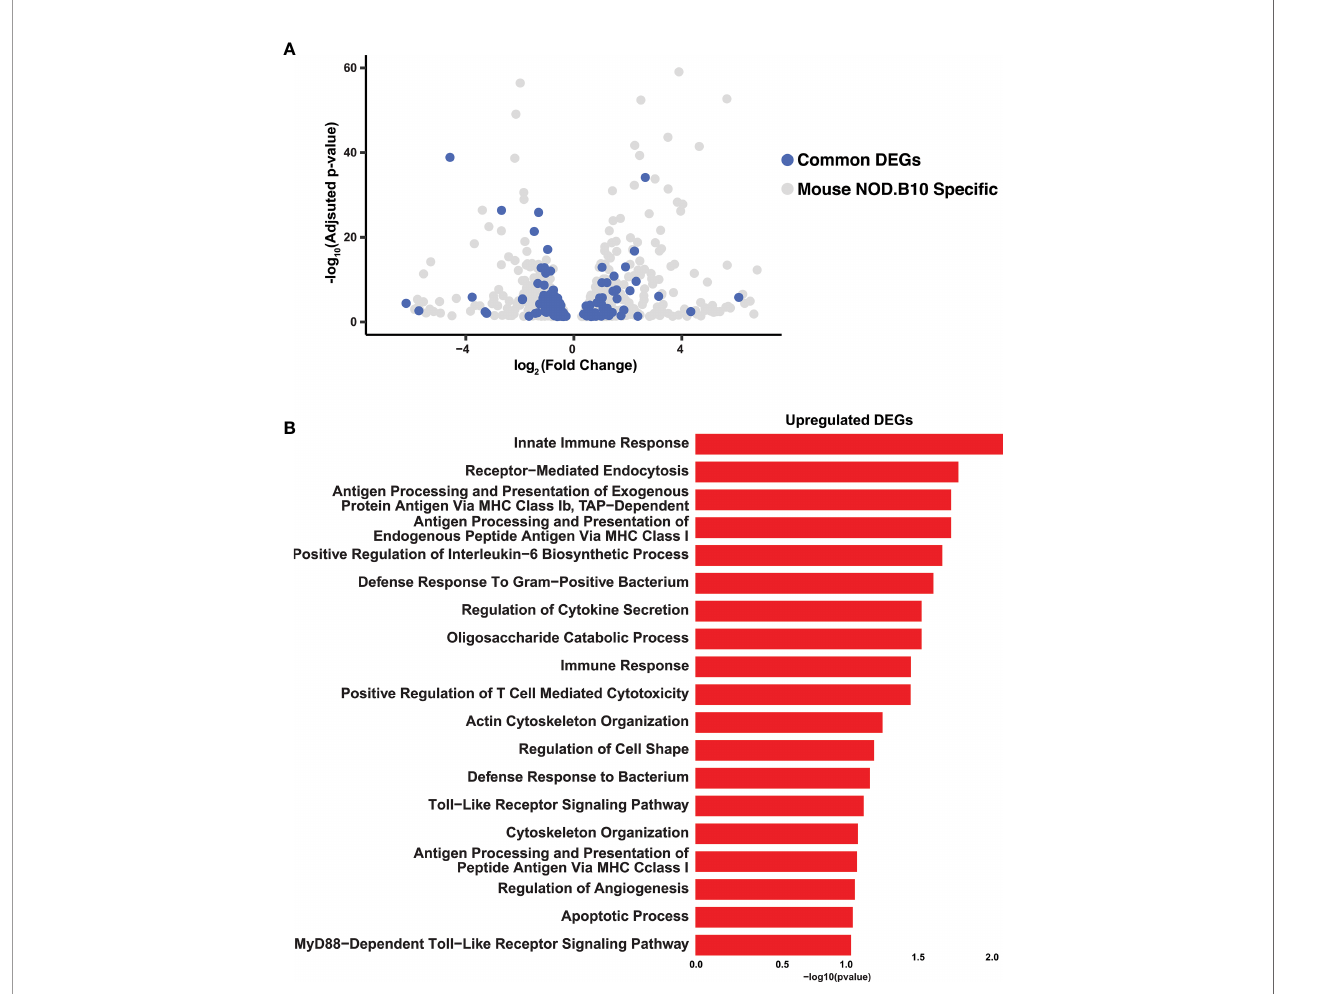
FIGURE 3 | Integrated Analysis of Mouse and Human Sjögren ’ s Syndrome Datasets. (A) Volcano plot shows the distribution of statistically signi fi cant upregulated and downregulated DEGs in NOD.B10 SMGs (grey dots) and common DEGs (blue dots) between mouse and human SS. (B) Bar plot highlights the biological processes enriched in the common upregulated DEGs identi fi ed between the NOD.B10 and human pSS